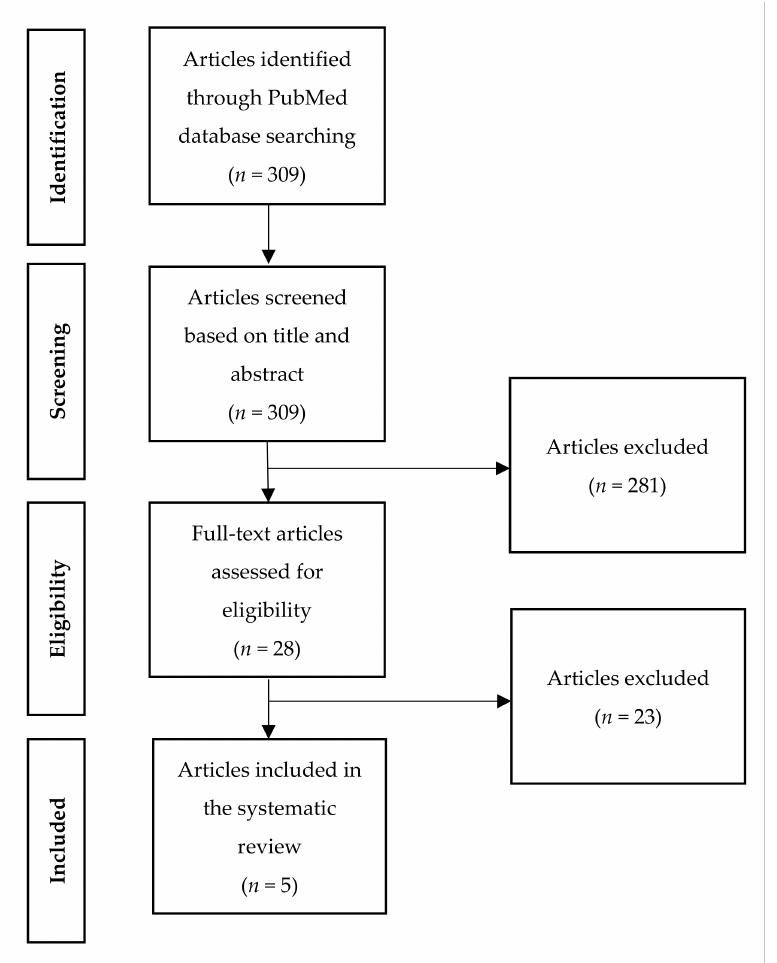
Figure 1. Flowchart of study